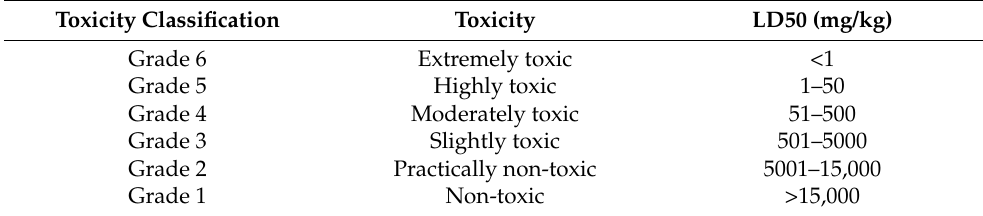
Table 1. Technical specification for chemical toxicity